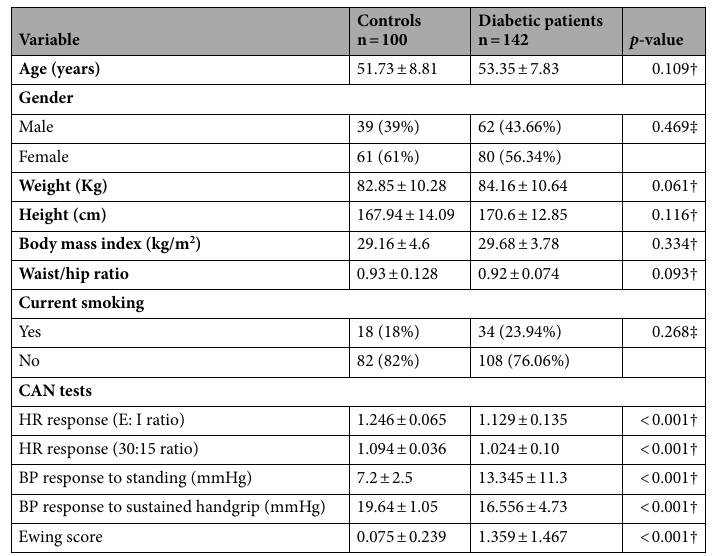
Table 1. Baseline characteristics of the study population. DM = diabetes mellitus; HR = heart rate; E: I = expiration: inspiration; BP = blood pressure, CAN = cardiac autonomic neuropathy; † t-test, ‡